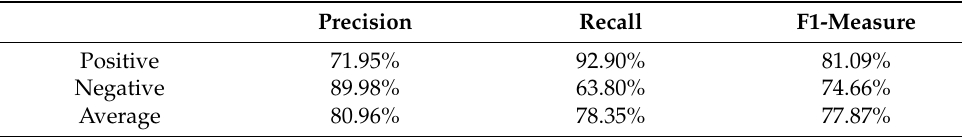
Table 14. Performance evaluation of ontology baseline approach.